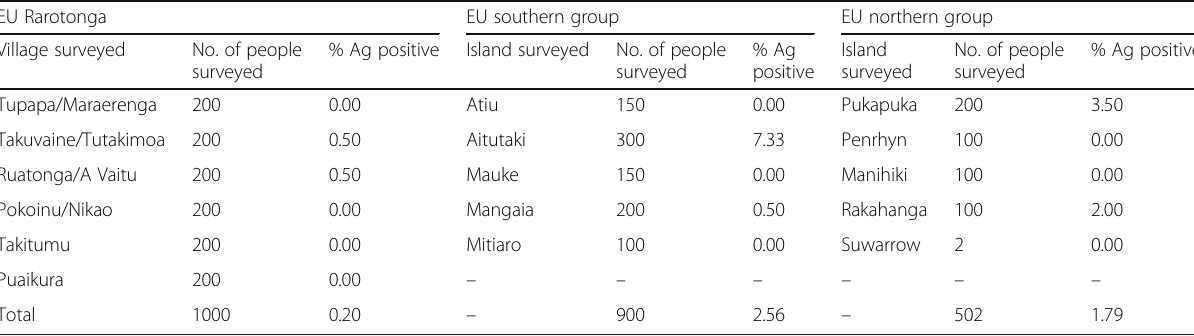
Table 4 Details of C-Survey, 2005